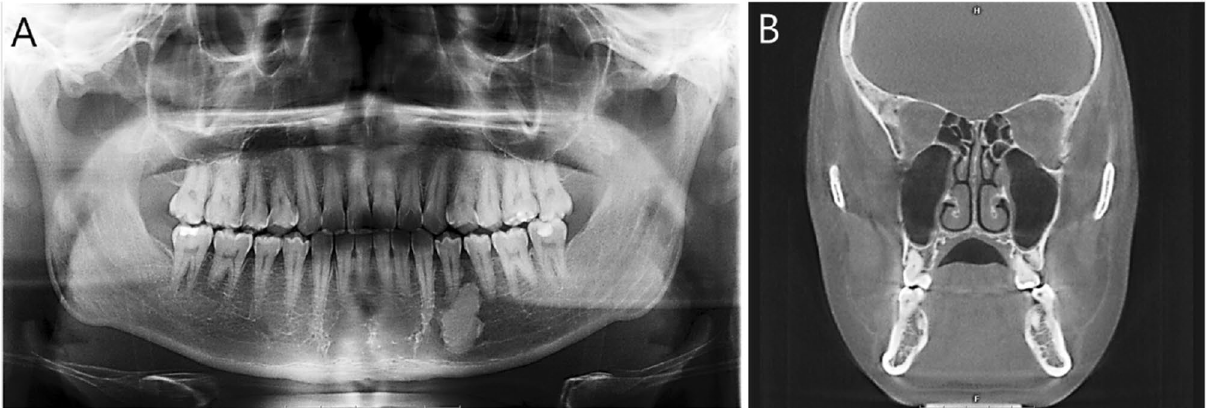
Figure 2. A panoramic image of a 23-year-old male patient seemed to show inflammation of paranasal sinuses based on the haziness of both sinuses, and total opacification was suspected on the right maxillary sinus. However, 3D CBCT image showed clear sinuses without any inflammation. ( A ) Panoramic radiograph, ( B ) clear sinuses in a CBCT